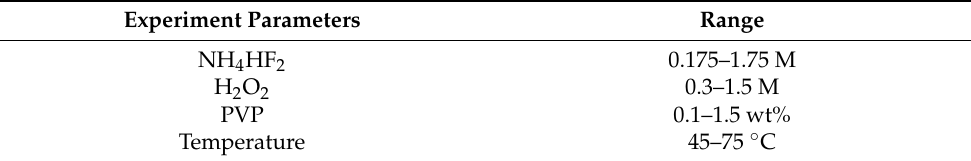
Table 1. Experiment parameters used in Ag@PVP–ACE for fabricating inverted pyramid.